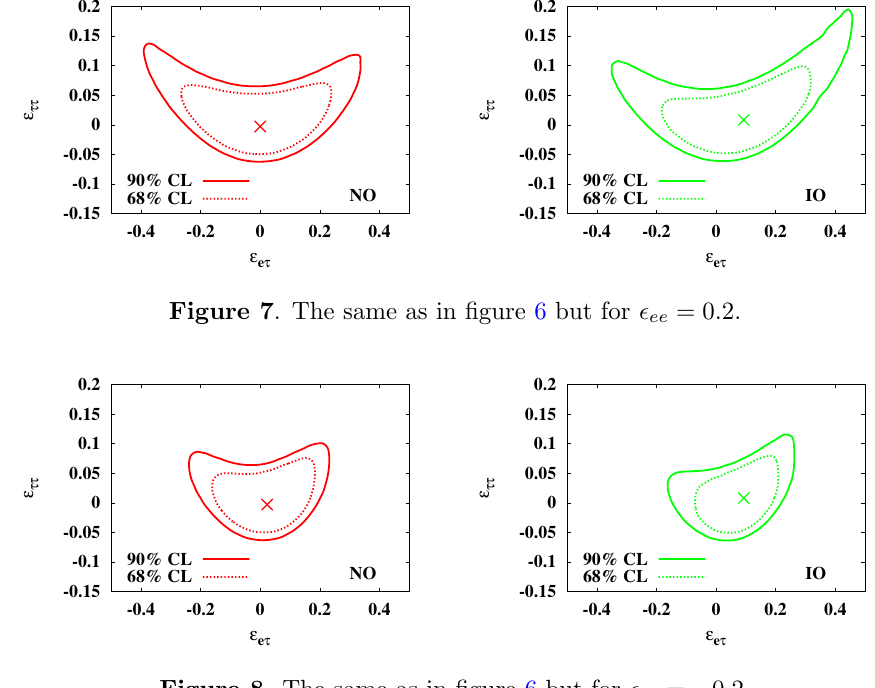
Figure 8 . The same as in (cid:12)gure 6 but for (cid:15) ee = (cid:0) 0 :